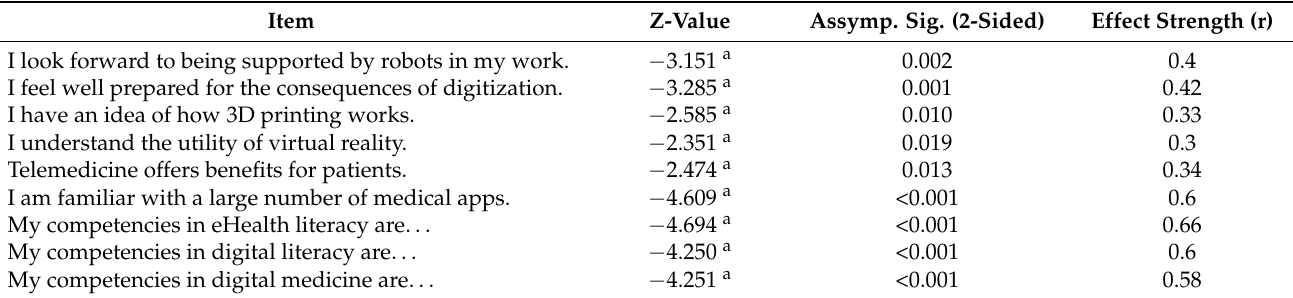
Table 5. The results of the Wilcoxon signed-rank test on the pseudonymized pairs at T2.